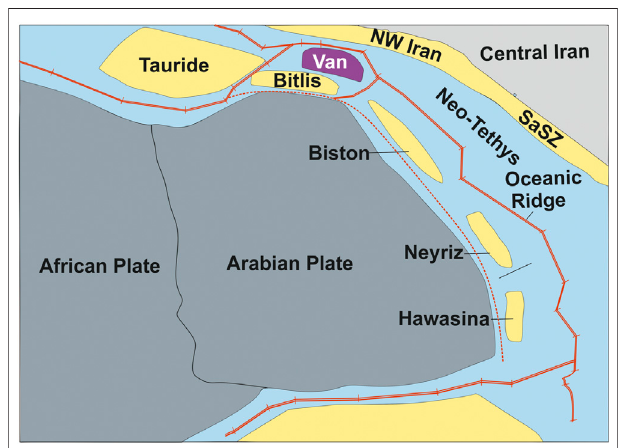
FIGURE 1 | Paleogeographic maps during the Late Jurassic-Early Cretaceous (Jassim and Goff, 2006) show that the Neotethys Ocean surrounded some microcontinents, such as Taurides – Anatolides and Biston – Avoramanm,Bilitis,andVanmicrocontinents,whichwereadded by the authors in this research.